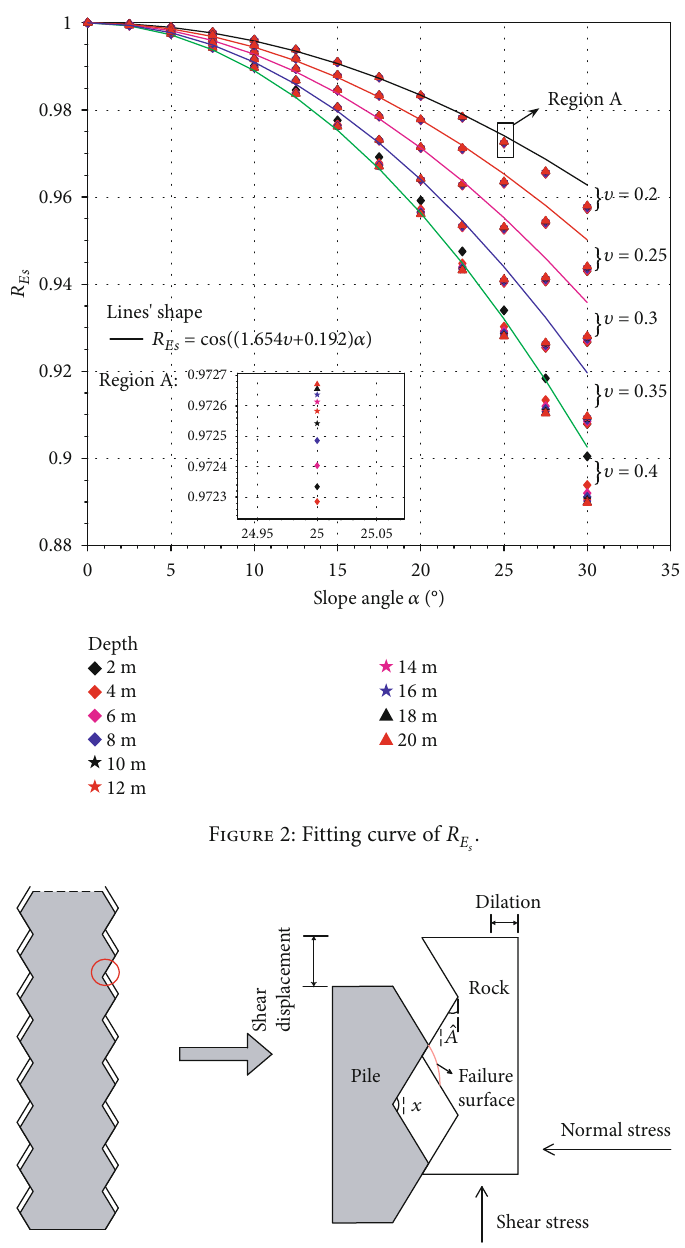
Figure 3: Shear motion of